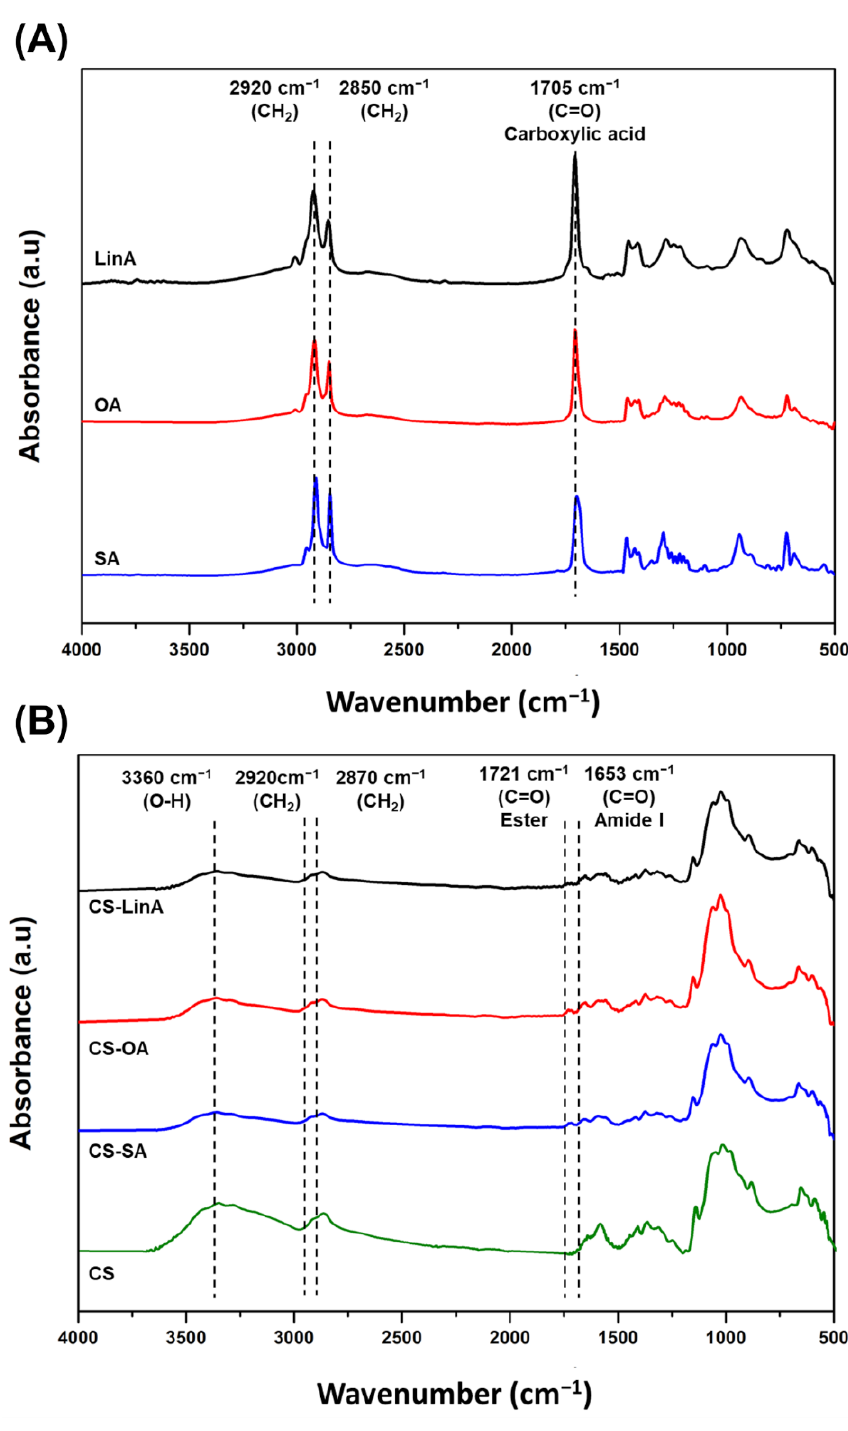
Figure 3. FTIR-ATR spectra of ( A ) commercial FAs, and ( B ) CS-FA derivatives.